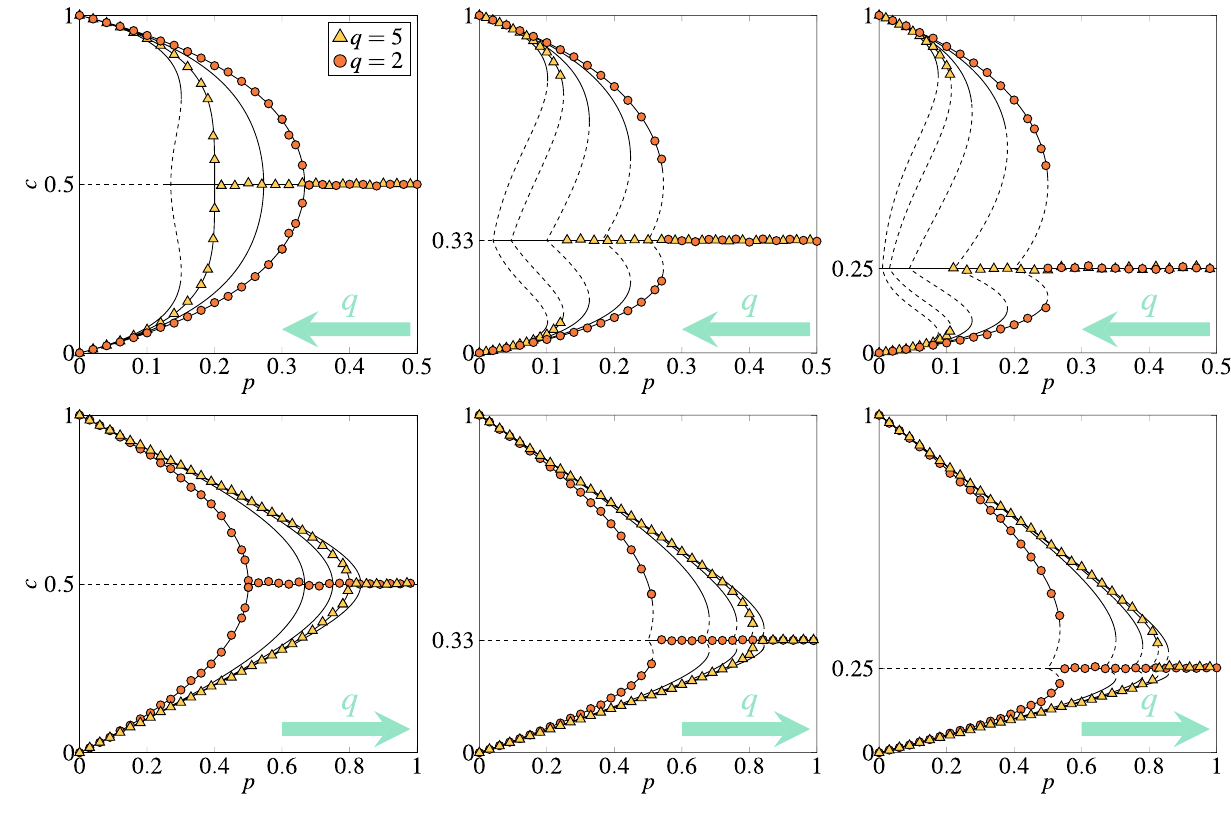
Figure 7. Dependence between the stationary concentration of agents in state 0 and probability of independence p within the annealed (upper panels) and quenched (bottom panels) approach for different values of the influence group size q = { 2, 3, 4, 5, 6 } . Arrows in the right corners of subplots indicate the direction in which q increases. The number of states: s = 2 (left column), s = 3 (middle column) and s = 4 (right column). Lines represent the solutions of Eqs. (12) and (30): solid and dashed lines correspond to stable and unstable steady states, respectively. Note that for s = 2 we have only four curves, the reason for that is that for q = 2 and q = 3 exactly the same results are obtained. Symbols represent the outcome from MC simulations for the system size N = 5 × 10 5 performed from initial condition c 0 = 1, c 1 = c 2 = 0 . The results are averaged over ten runs and collected after t = 2 × 10 4 MCS. Symbols above the line c = 1 / s correspond to the concentration of state 0, whereas symbols below the line c = 1 / s represent concentration of all others.